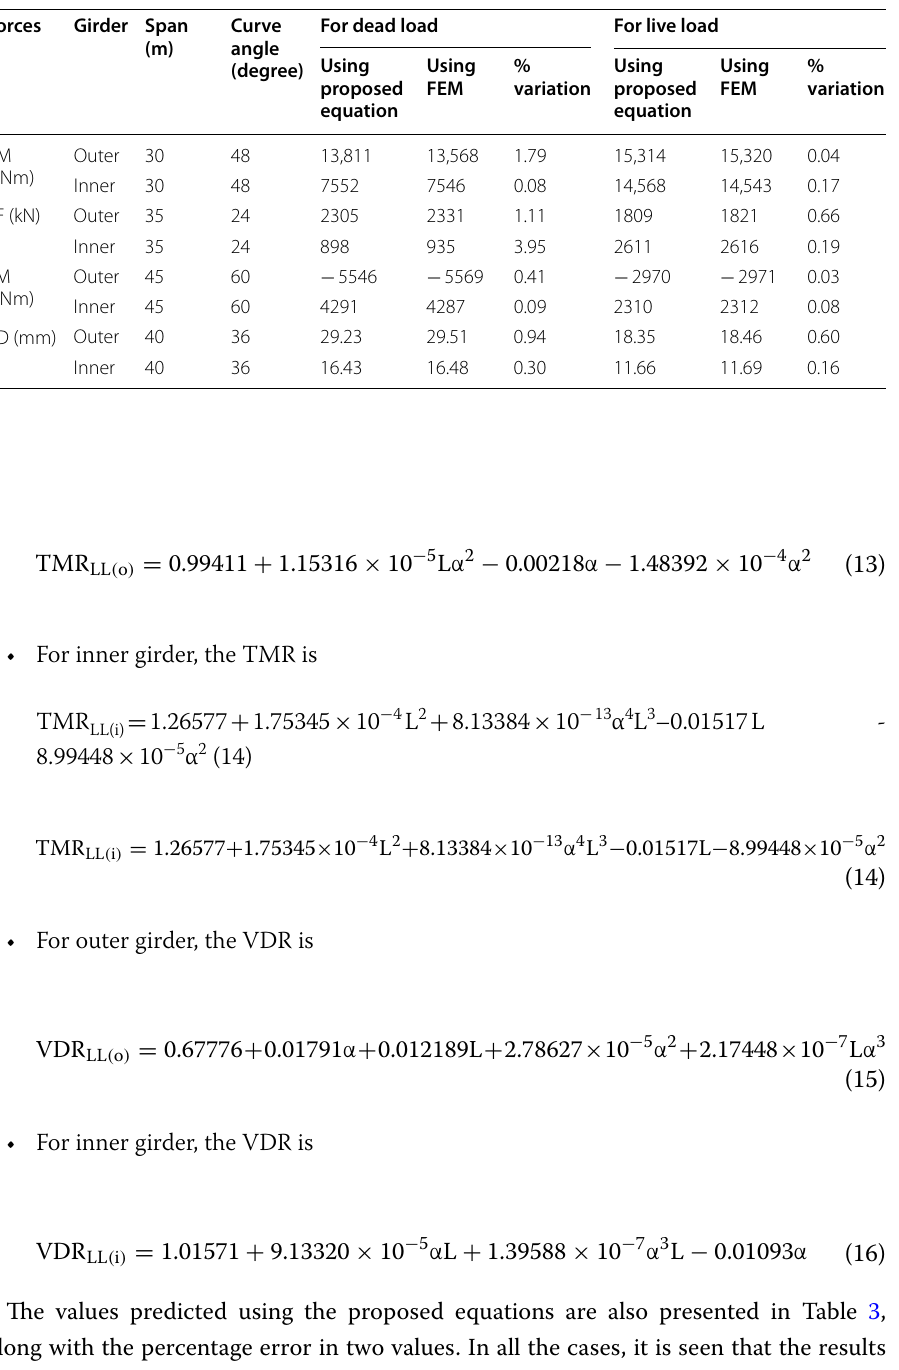
Using % FEM variation